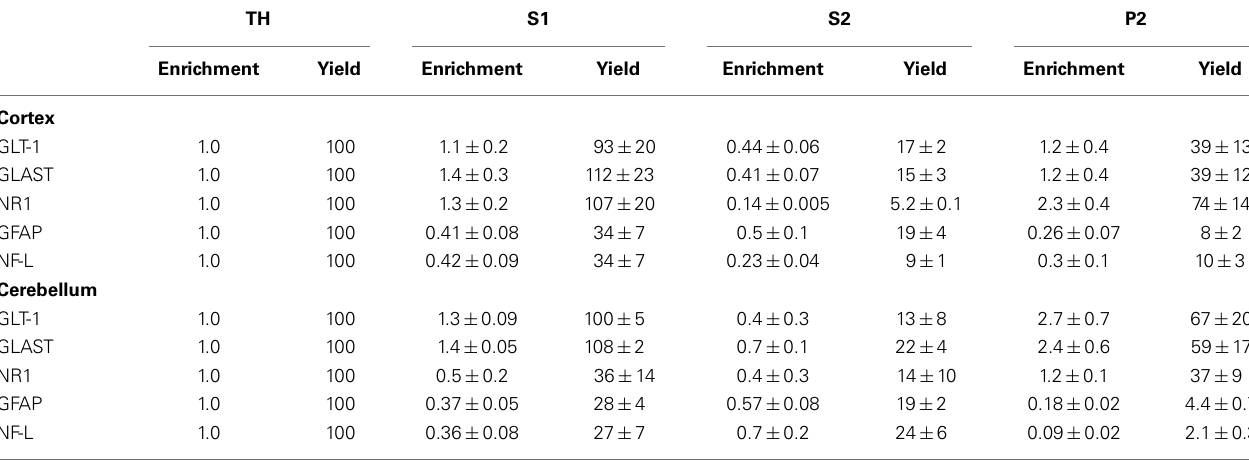
Table 1 |Analyses of neuronal and astroglial proteins in tissue homogenate (TH) and various subcellular fractionations as described in Section “Materials and Methods.” TH S1 S2 P2 Yield Enrichment Yield Enrichment Yield Enrichment